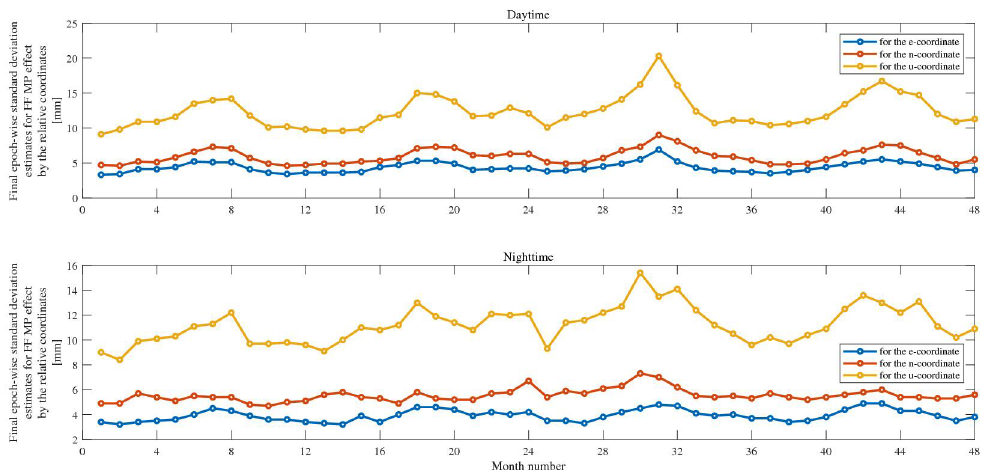
Figure 3. Final epoch-wise standard deviation estimates by the relative coordinates ( e , n and u ) for the effect of FF MP, obtained for the daytime and the nighttime period